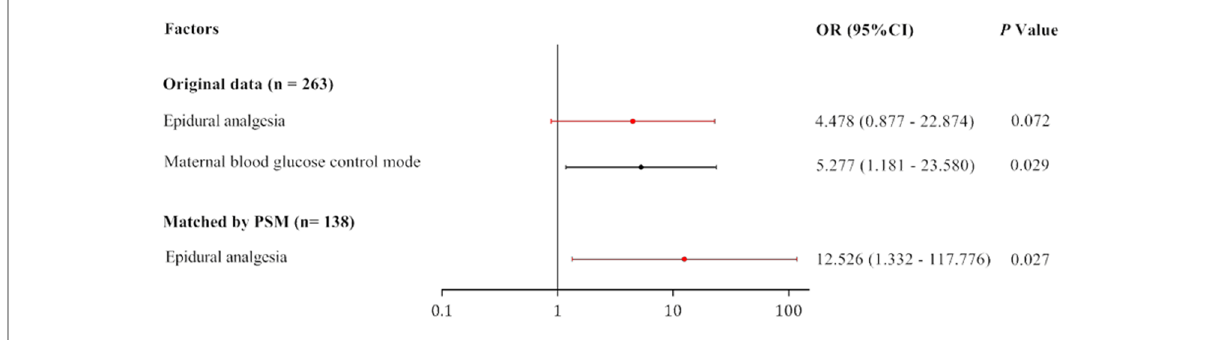
FIGURE 2 Independent in fl uencing factor (IIF) on the rate of neonate transfer to the NICU for hypoglycemia treatment before and after PSM.